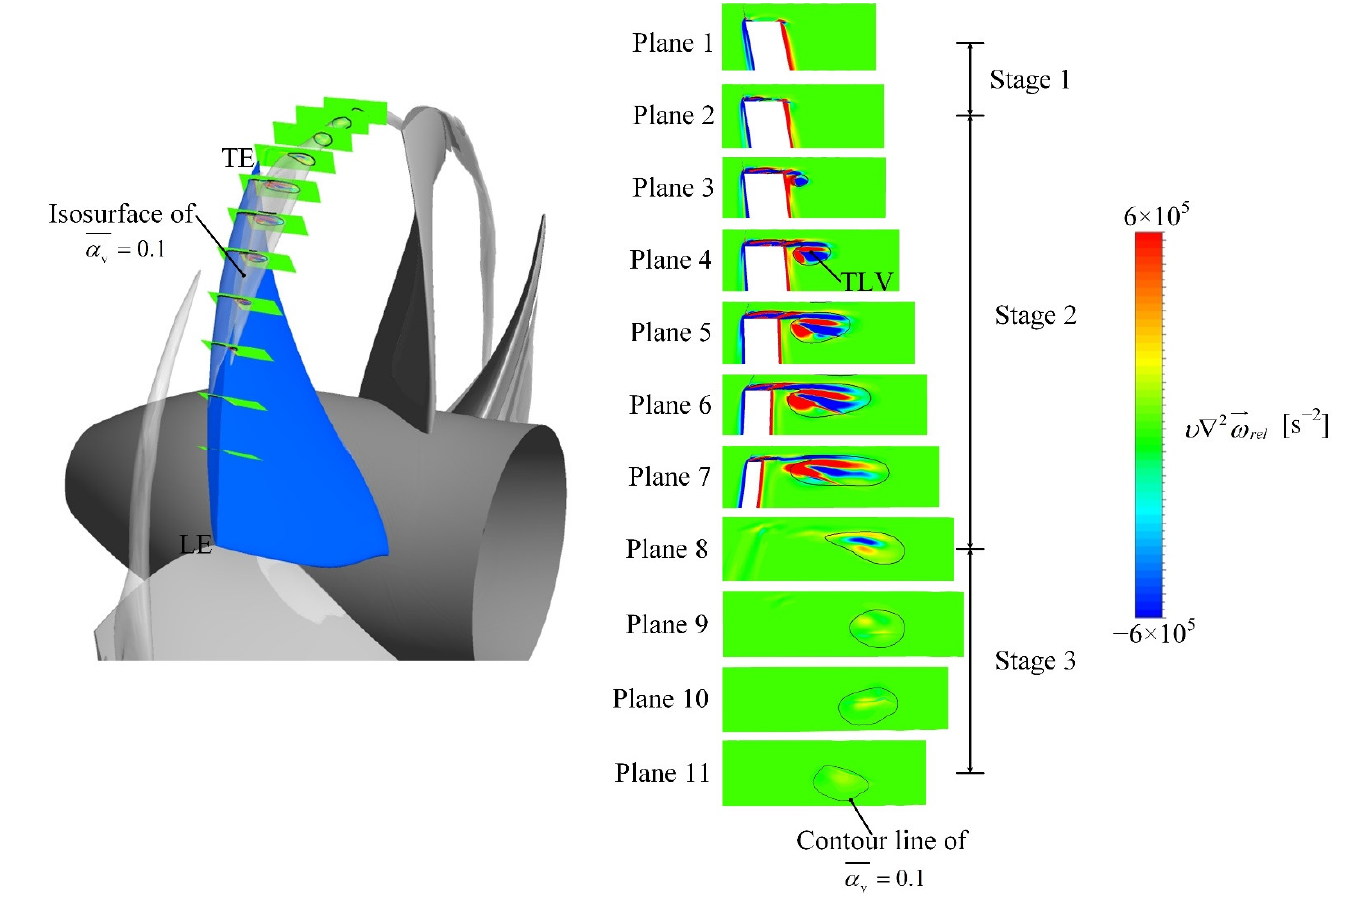
Figure 11. Viscous-diffusion term.